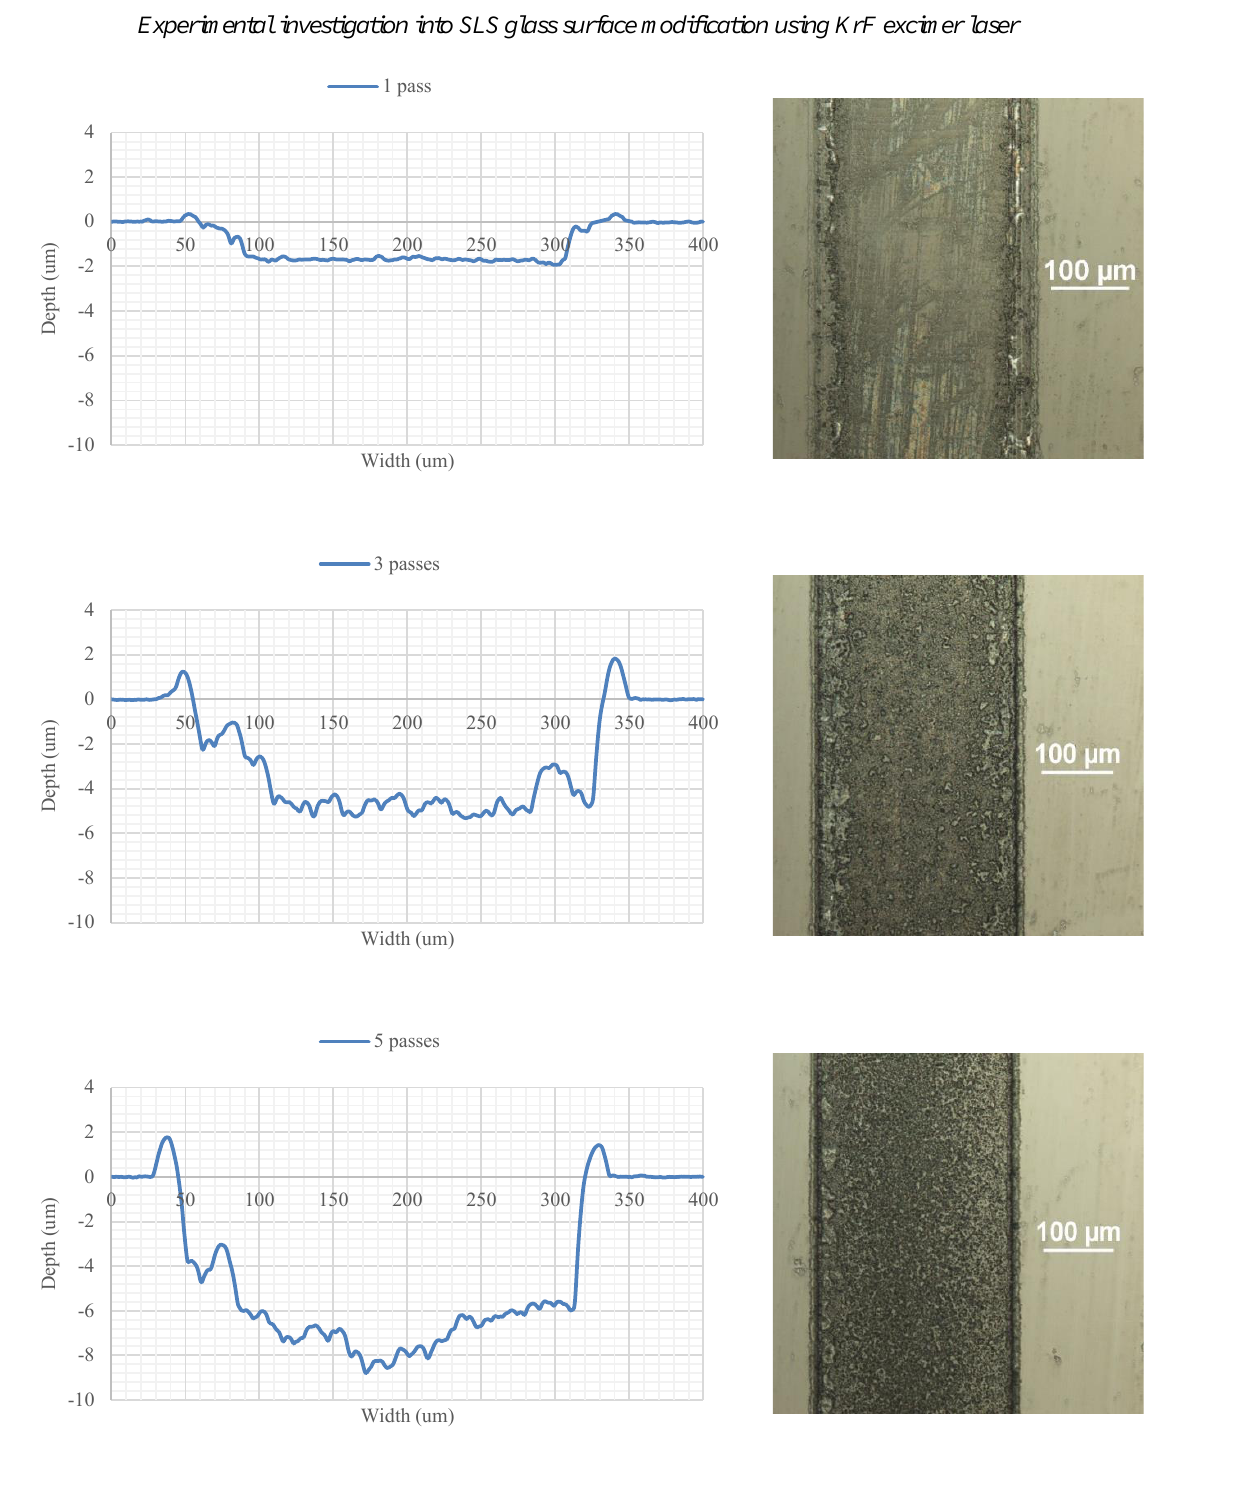
Fig. 6 Ablation profile and top view of lines for different depths obtained by increasing the number of laser passes on one